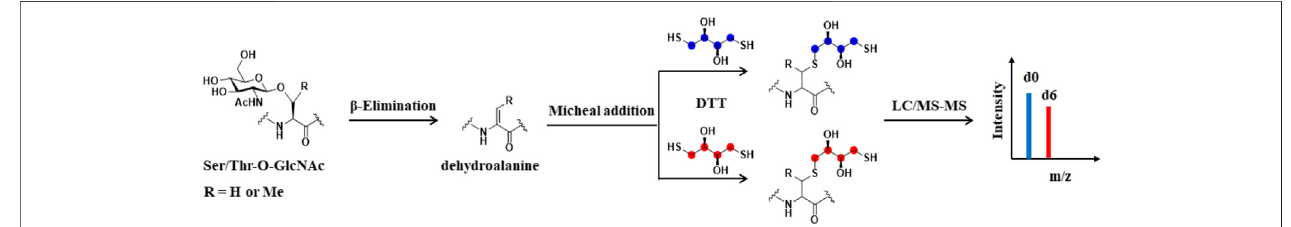
FIGURE 5 | Schematic of BEMAD-based Quantitative strategy. O-GlcNAcylated serine and threonine residues can be converted to dehydroalanine by β -elimination reaction. Subsequently, isotope-labeled lightDTT (DTTd0) or heavy DTT (DTT-d6) isadded toO-GlcNAcylated peptides byMichael addition. The peptides are mixed and analyzed by LC-MS/MS. The red balls and blue balls represent heavy or light labeling sites, respectively.